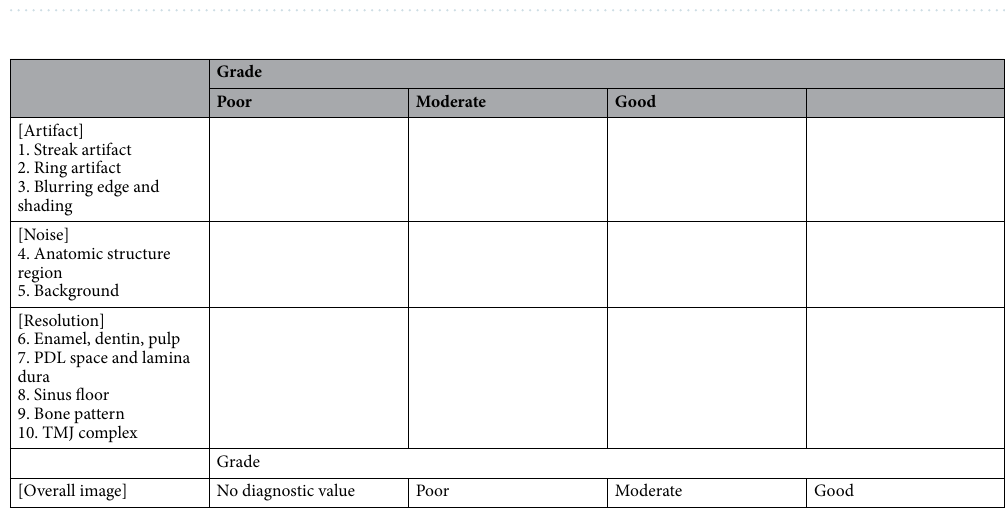
Figure 2. Surface deviation of synthetic CBCT. ( a ) The deviation of the overall three-dimensional model. ( b ) The deviation measurement in axial (maxilla and mandible) and coronal (anterior and posterior) planes. The black line indicates the surface of the original CBCT, and the colored line indicates deviated area. CBCT, cone- beam computed tomography; syCBCT, synthetic CBCT.